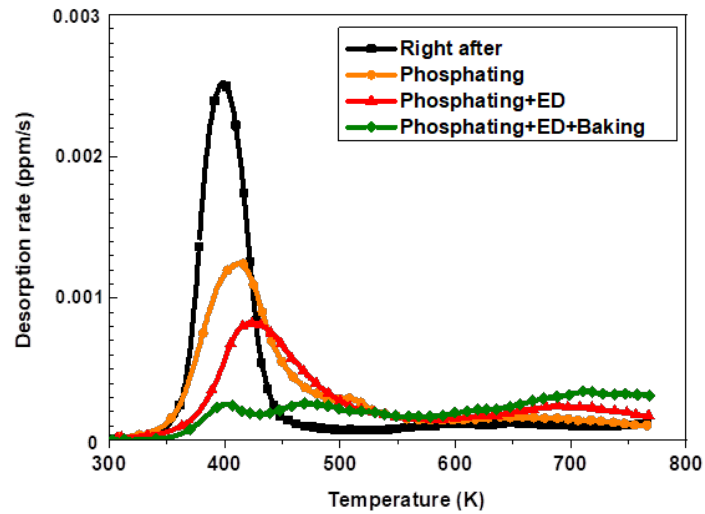
Figure 8. The TDS curves and behavior of diffusible hydrogen after automotive sequential process on the 300 s specimen of 1.8 GPa hot-stamped steel.